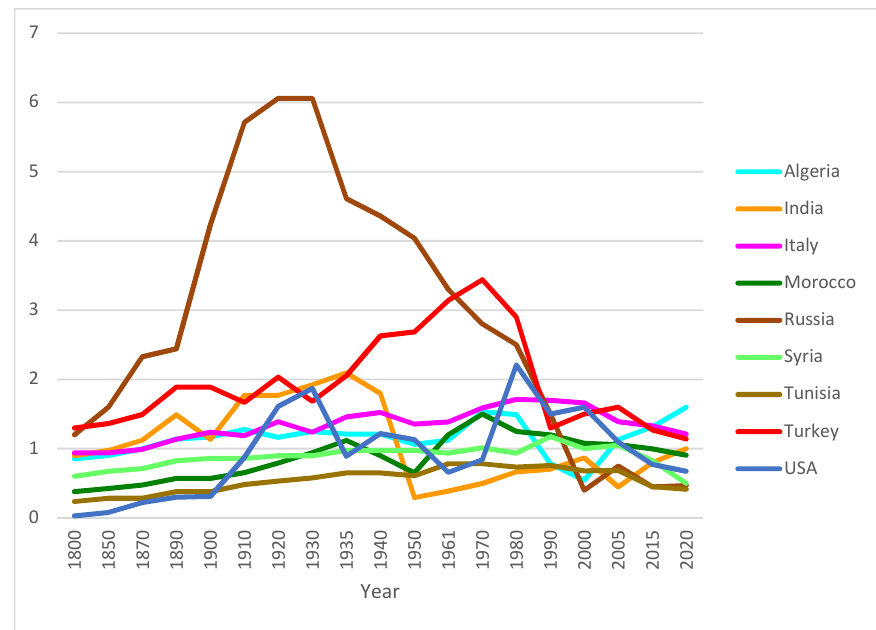
Figure 1. Historical area (Mha) in the nine main durum wheat cultivating countries in 1800–2020. Sources of information: [12,13,15,17–25,37,39,40,89].